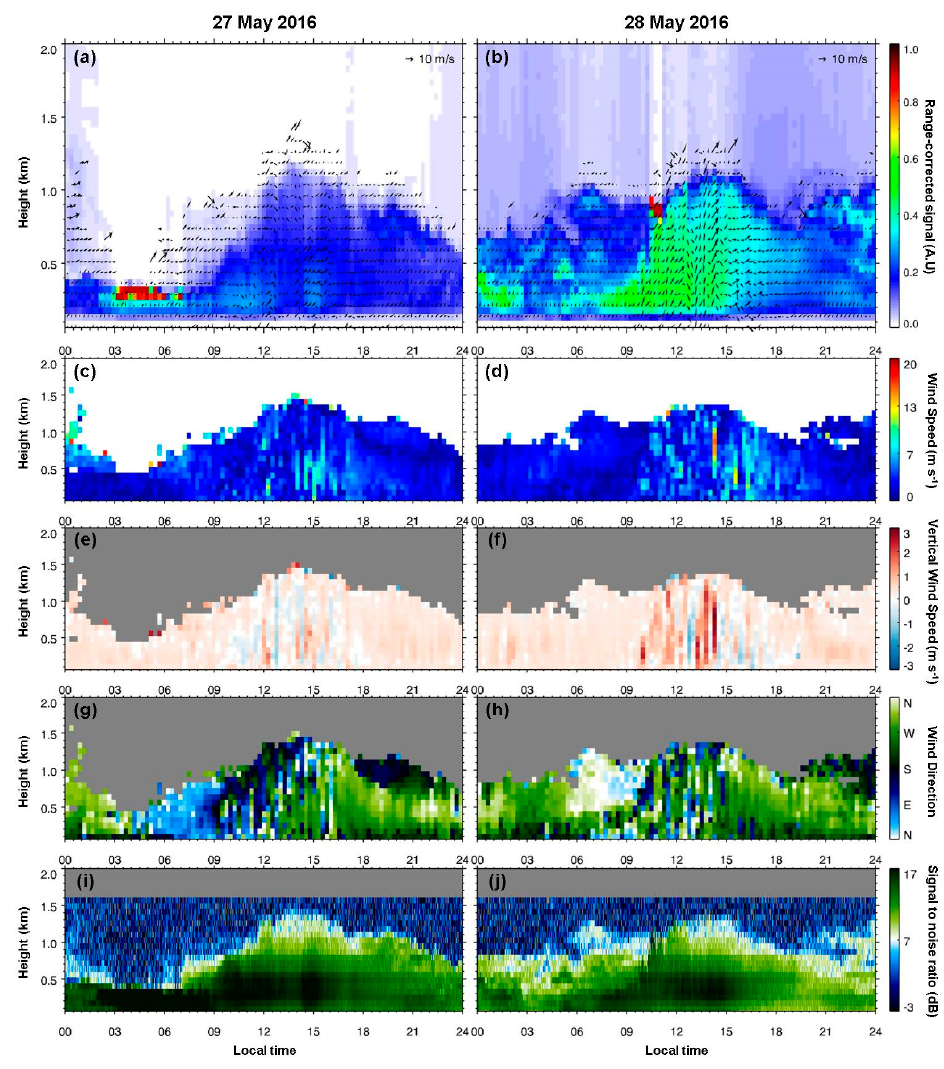
Figure 6. Diurnal variation in the aerosol backscatter range-corrected signal with wind vectors ( a , b ), wind speed ( c , d ), vertical wind speed ( e , f ), wind direction ( g , h ) and wind Doppler lidar signal-to-noise ratio ( i , j ) measured during 27 May 2016 (left column) and 28 May 2016 (right column).